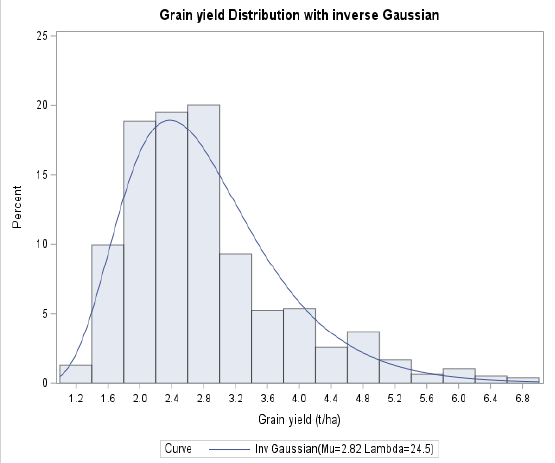
Figure 2. Histogram of Grain yield relative to inverse Gaussian. Grain yield is represented in X-axis, and the percent of the values in a certain interval is represented in Y-axis.